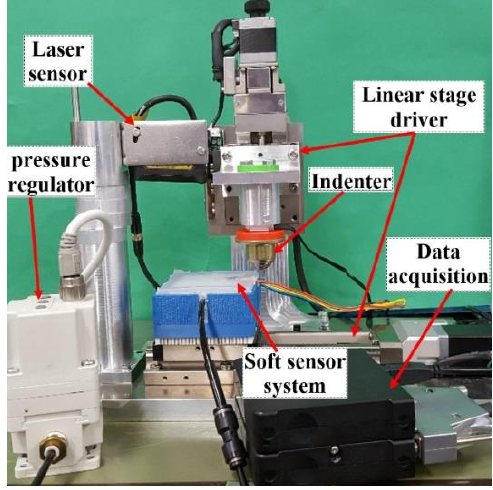
` Figure 7. Experimental setup: sensing system is set on horizontal linear stage. Indenter is fixed to vertical linear stage. Skin is inflated by air regulator. Laser sensor measures inflated skin’s height. Data from accelerometer are obtained through data acquisition system before being sent to computer.